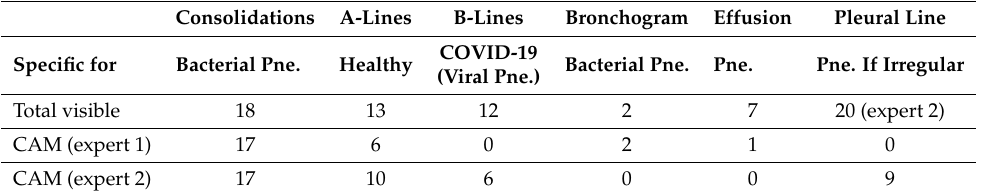
Table A3. Pathological patterns visible and highlighted by class activation maps of our model. Pneu abbreviated pneumonia. The model focuses on consolidations, A-lines and the pleural line. Consolidations A-Lines